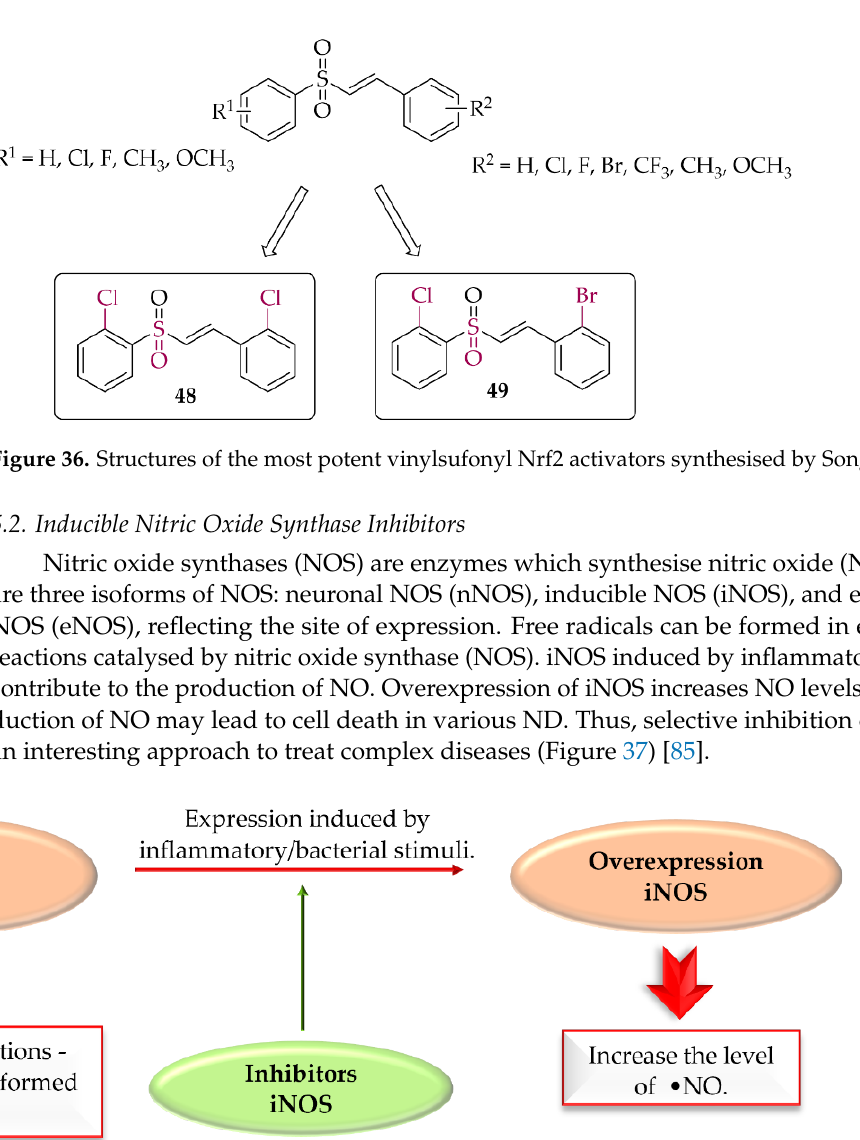
Figure 36. Structures of the most potent vinylsufonyl Nrf2 activators synthesised by Song et al. [84].